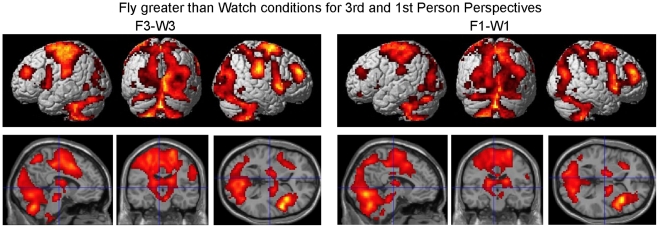
Differential brain activity between flying and watching conditions.Random-effects results of the contrast between flying and watching conditions for the 3rd person perspective (F3-W3) and the 1st person perspective (F1-W1) (pFDR <0.05 corrected for multiple comparisons).